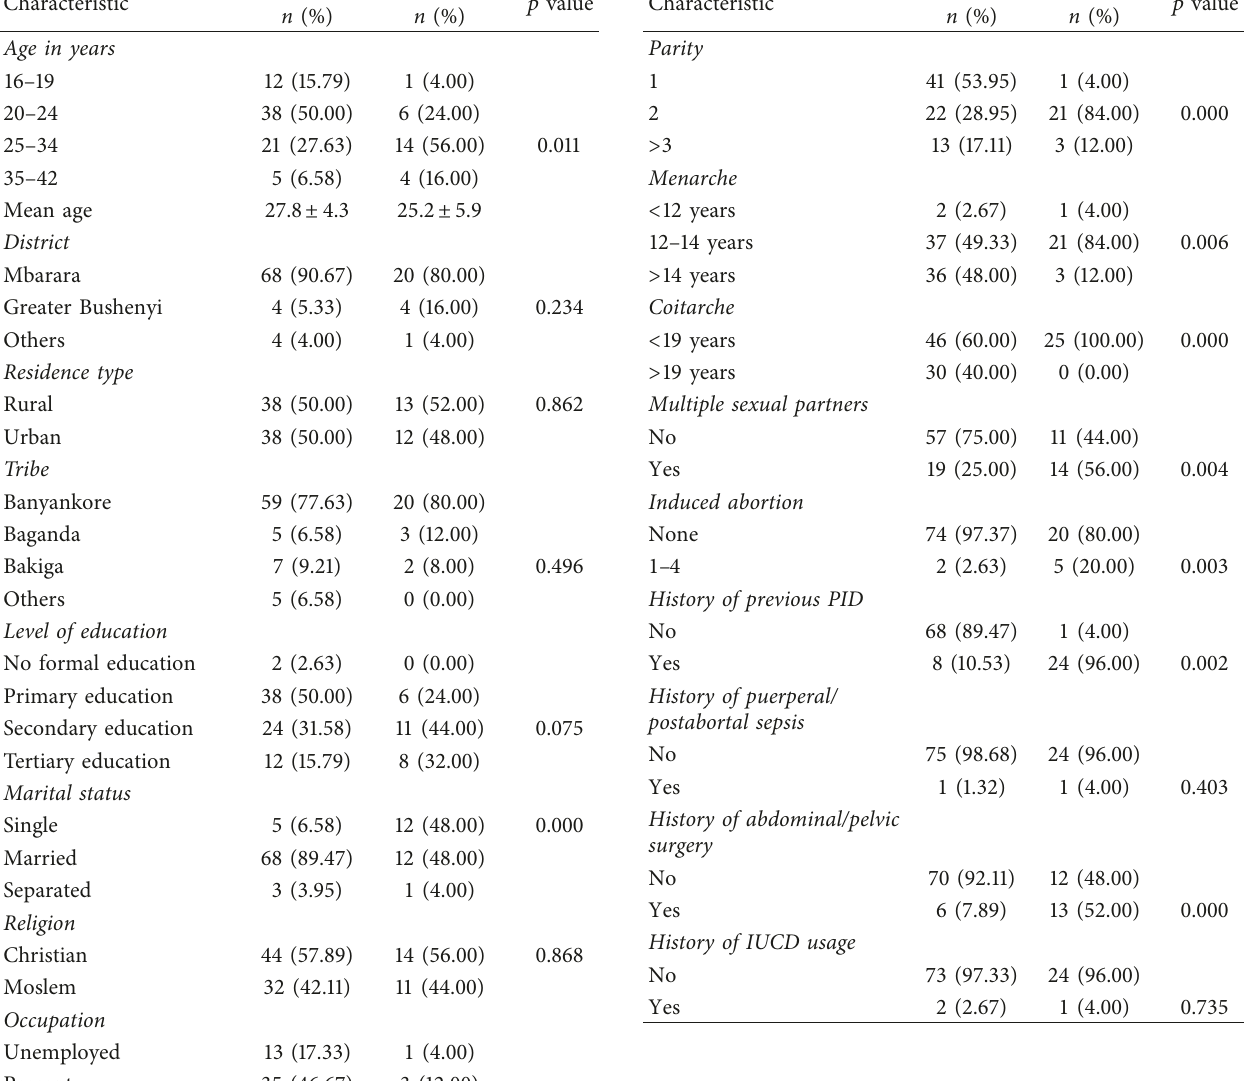
Table 1: Sociodemographic characteristics ( N � 101). Table 2: Sexual and reproductive characteristics ( N � 101). Characteristic